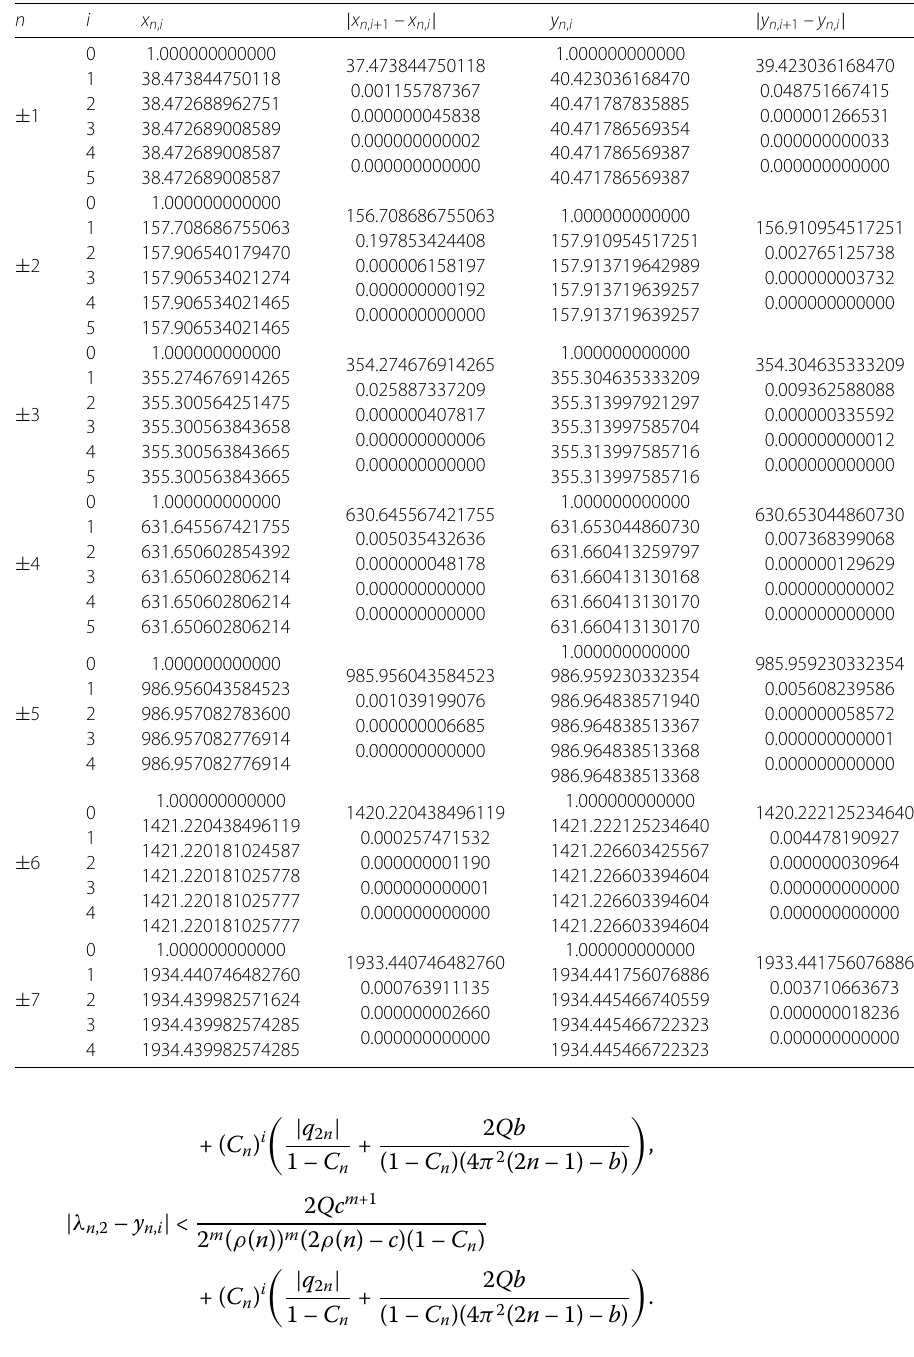
Table 2 Estimations of eigenvalues for q ( x ) = 2cos(2 π x ) + 2cos(4 π x